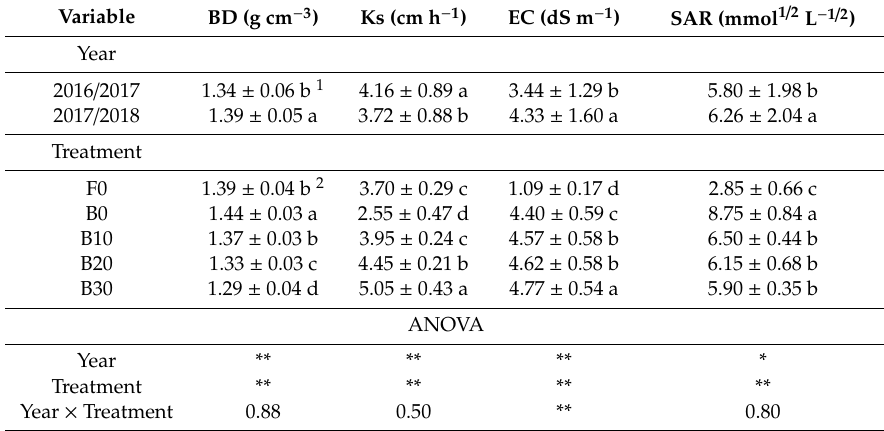
Table 3. Main e ff ects of year and treatment on topsoil (0–20 cm) bulk density (BD), saturated